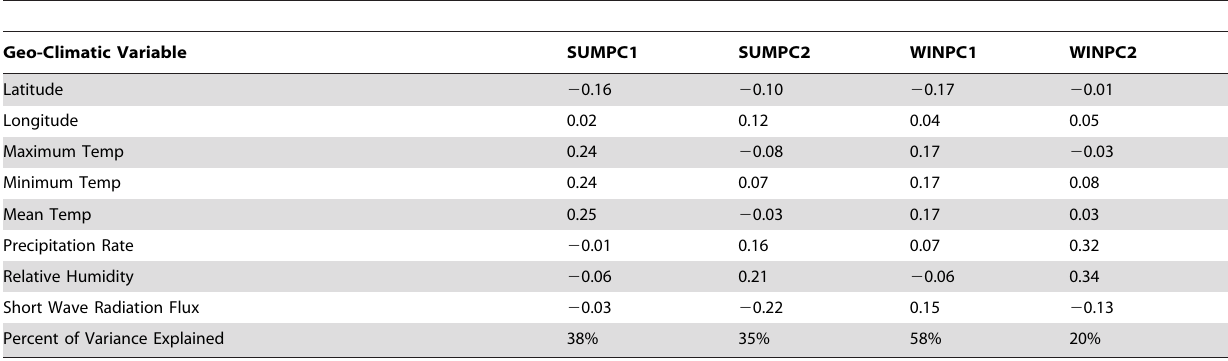
Table 1. The contribution of each geo-climatic variable to each of our four principal components, scaled such that the absolute value of the entries in each column sum to one (up to rounding error).